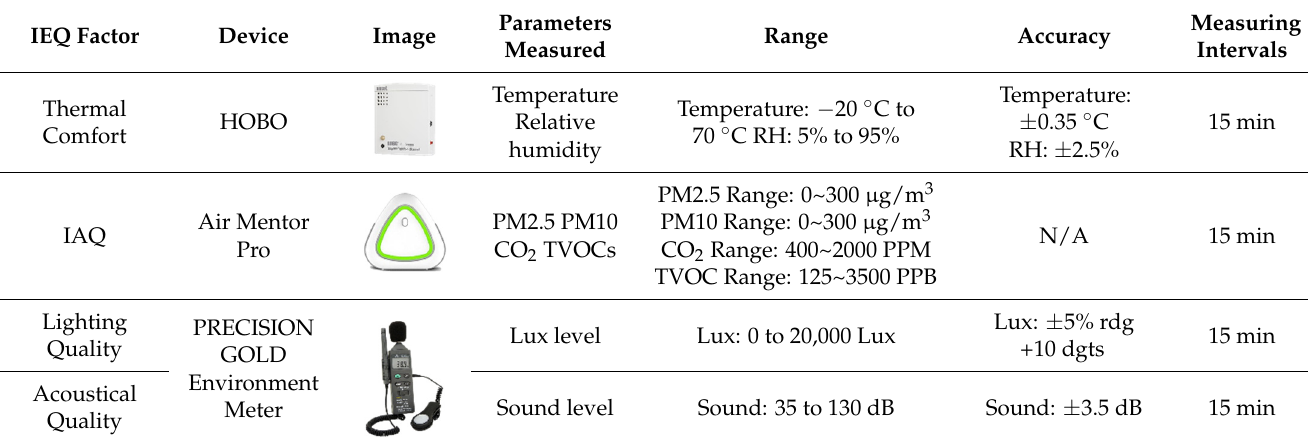
Table 4. Devices used, parameters measured, and measuring intervals.